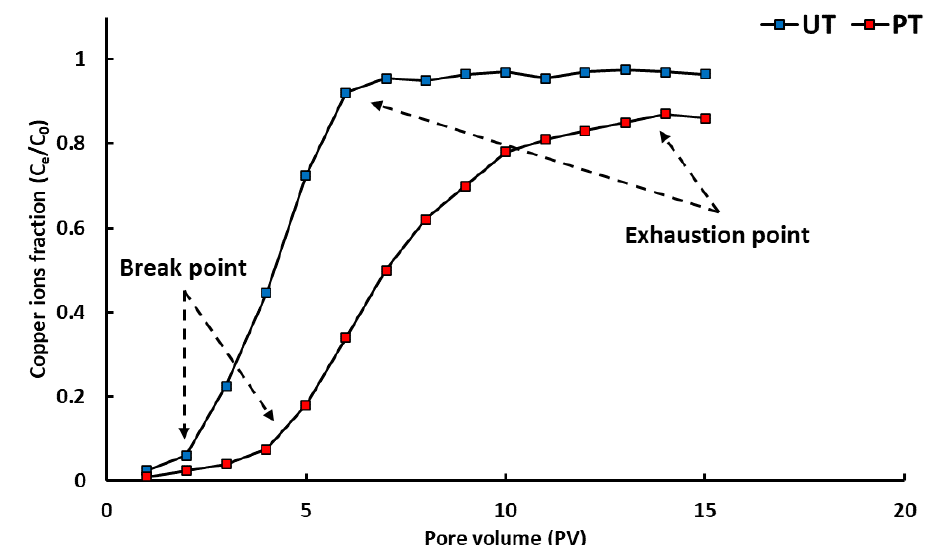
Figure 10. Breakthrough profile for untreated and polymer-treated tailings while treating the copper ions solution (200 ppm).